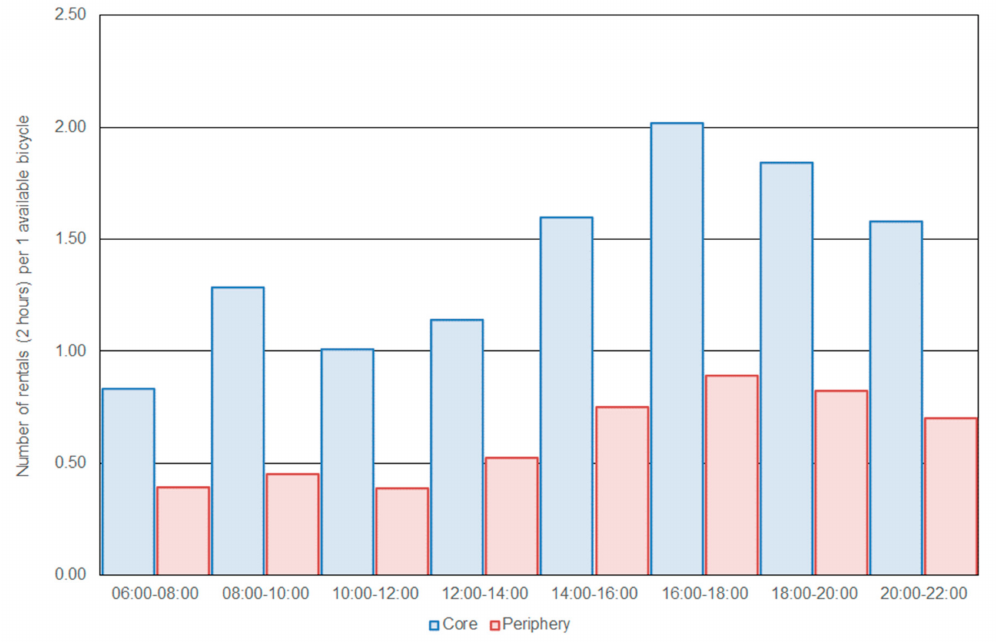
Figure 6. Di ff erence in relative intensity of using the public bike system in the core and in the periphery of MAGGS. Source: Author’s own